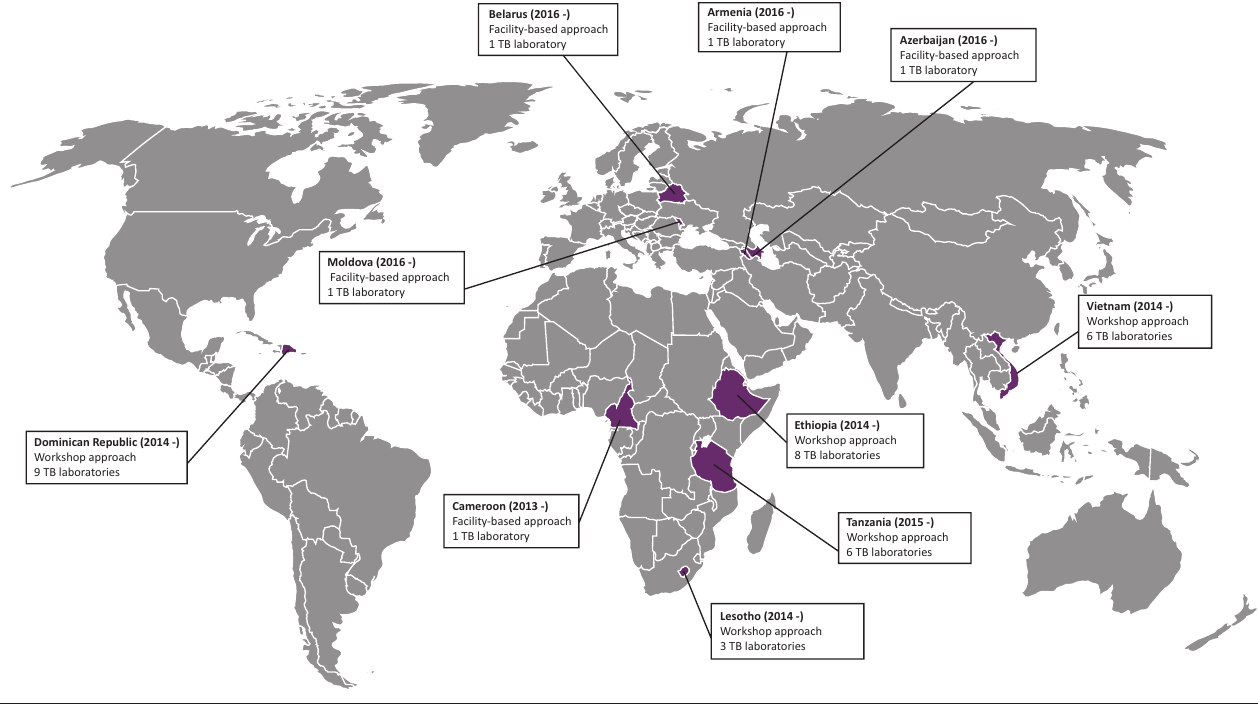
FIGURE 2: Implementation of TB SLMTA in 37 tuberculosis laboratories in 10 countries since 2013.